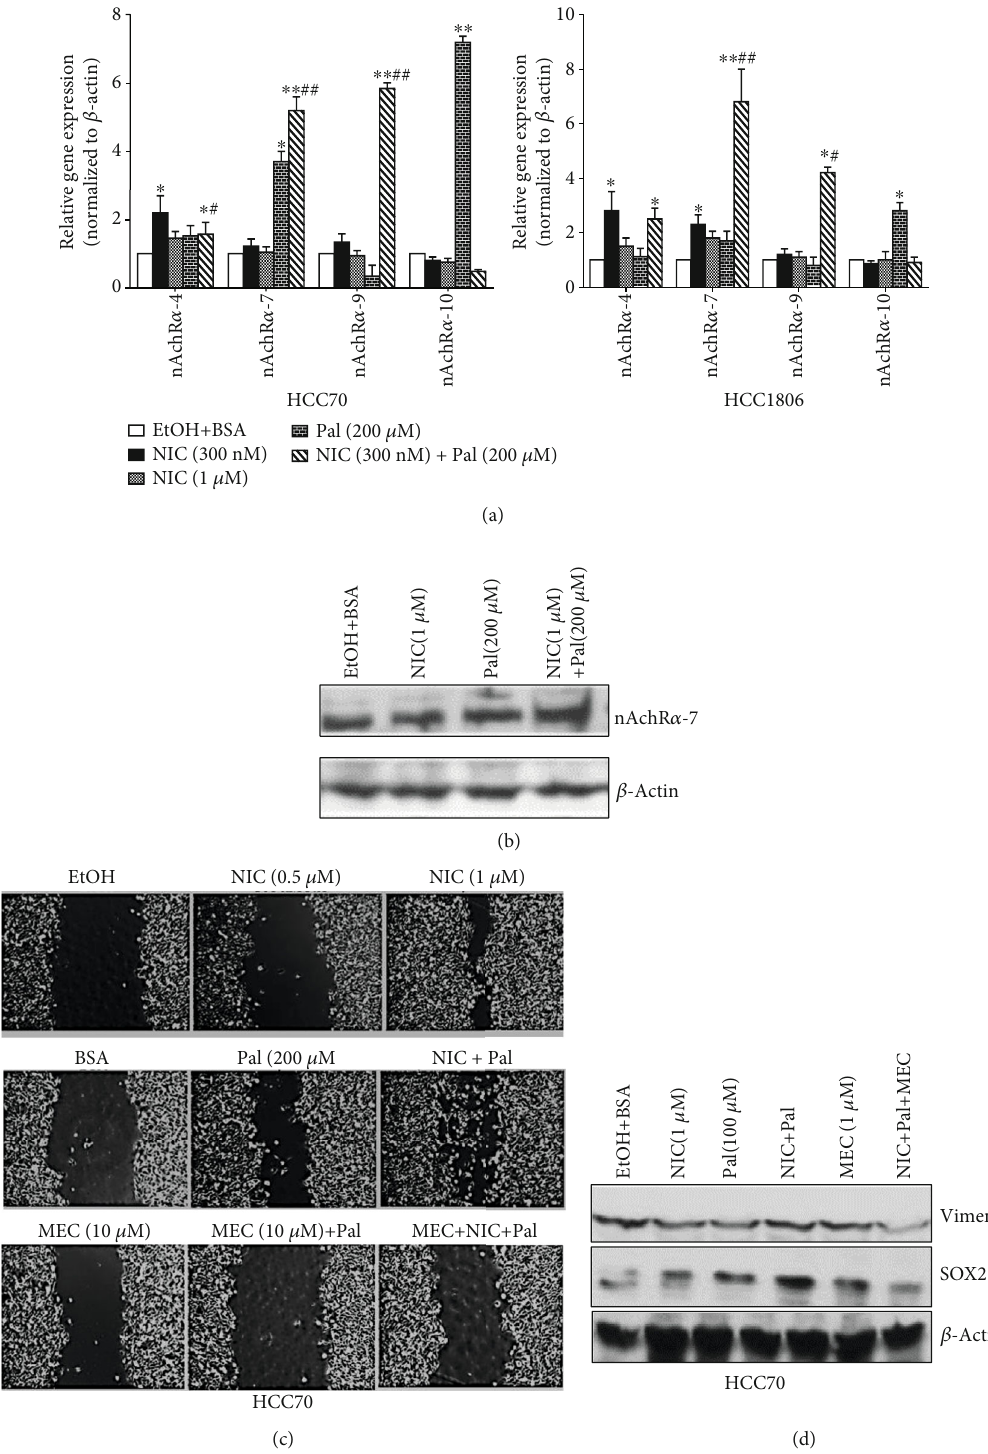
Figure 5: Treatment with MEC reduces NIC +Pal-mediated increase in vimentin and SOX2 in HCC70 cells. (a) Quantitative gene expression analysis of various nAchR isoforms in HCC70 (right panel) and HCC1806 (left panel) after various treatments. (b) Western blot analysis of nAchR α -7 in HCC70 cells treated with either NIC ± Pal for 72 h. (c) Cell invasion assay: HCC70 cells were plated in 6-well plates, grown to con fl uence, scratched, and further treated with NIC ± Pal with/without MEC for 72 h. (d) Immunoblot analysis of vimentin and SOX2 in HCC70 cells treated with NIC ± Pal with/without MEC for 72 hours. ∗ p ≤ 0 : 05 and ∗∗ p ≤ 0 : 01 compared to saline or # p ≤ 0 : 05 and ## p ≤ 0 : 01 compared to the NIC group alone ( n = 3